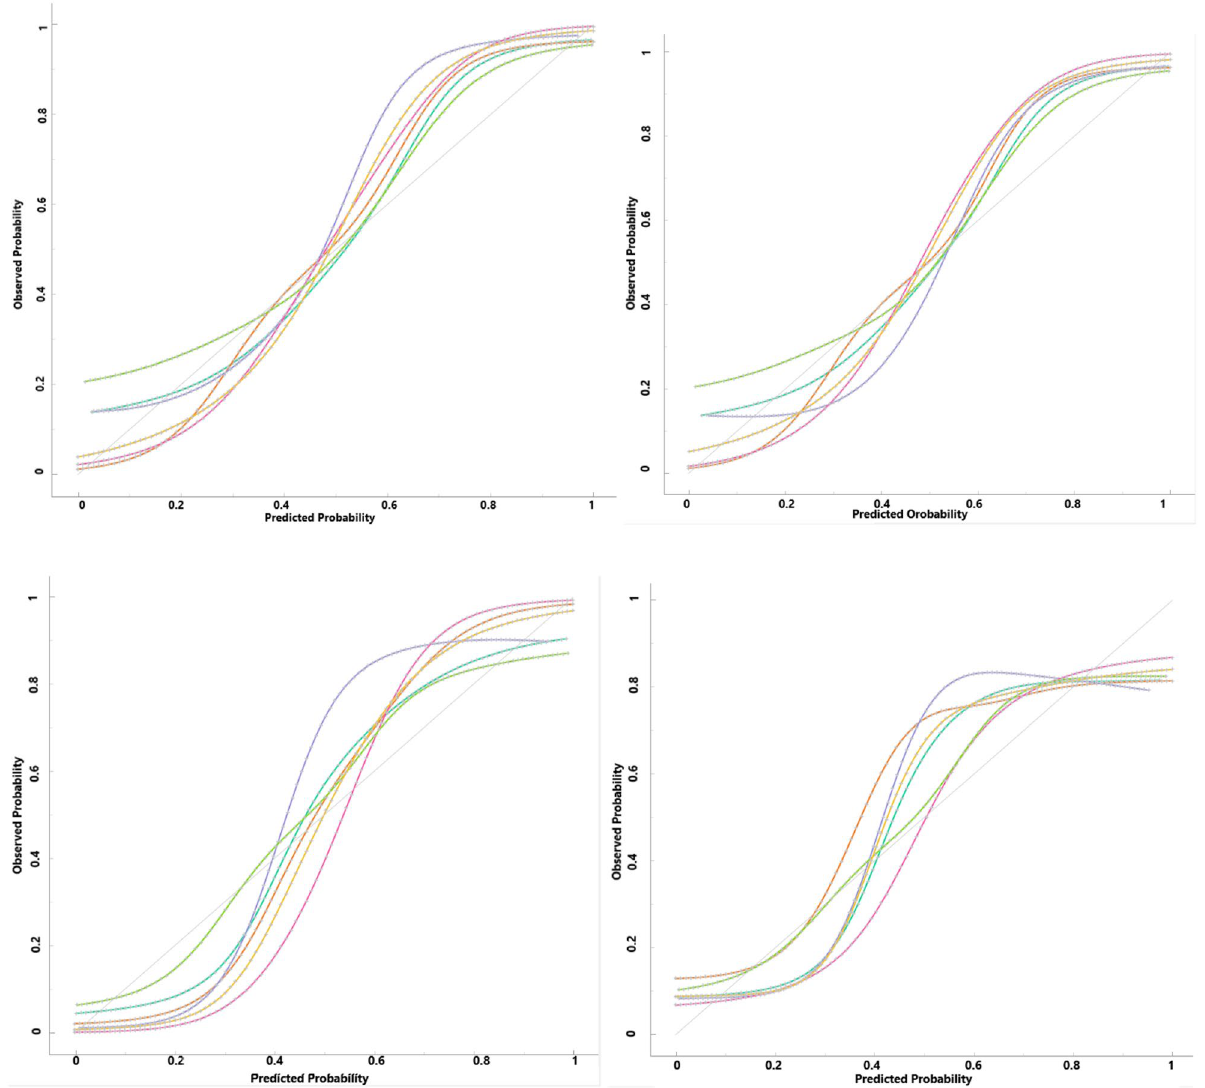
Figure 5. Calibration plots of class probabilities against those predicted by ML algorithms (Top left: Train original data, Top right: Test original data, Down left: Train balanced data, Down right: Test balanced